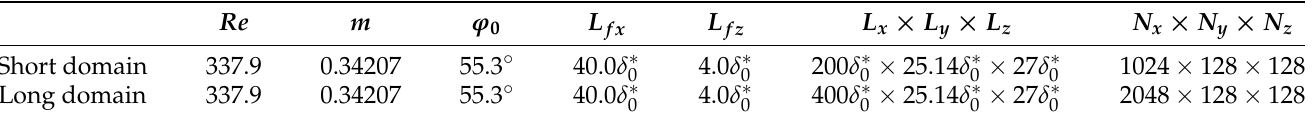
Table 1. Numerical Conditions.